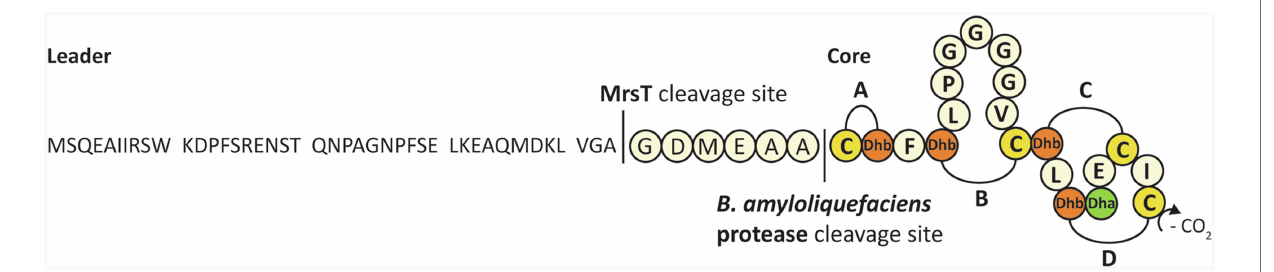
FIGURE 1 | The complete sequence, modification, and processing of mersacidin. The C-terminal cysteine is decarboxylated by MrsD. The four lanthionine rings, A to D, are installed by MrsM. Upon transportation out of the cell, the transporter and leader protease MrsT cleaves a large portion of the mersacidin leader (Viel et al., 2021). The six amino acids of the leader that remain attached to the core peptide keep mersacidin inactive, until they are cleaved off by a Bacillus amyloliquefaciens extracellular